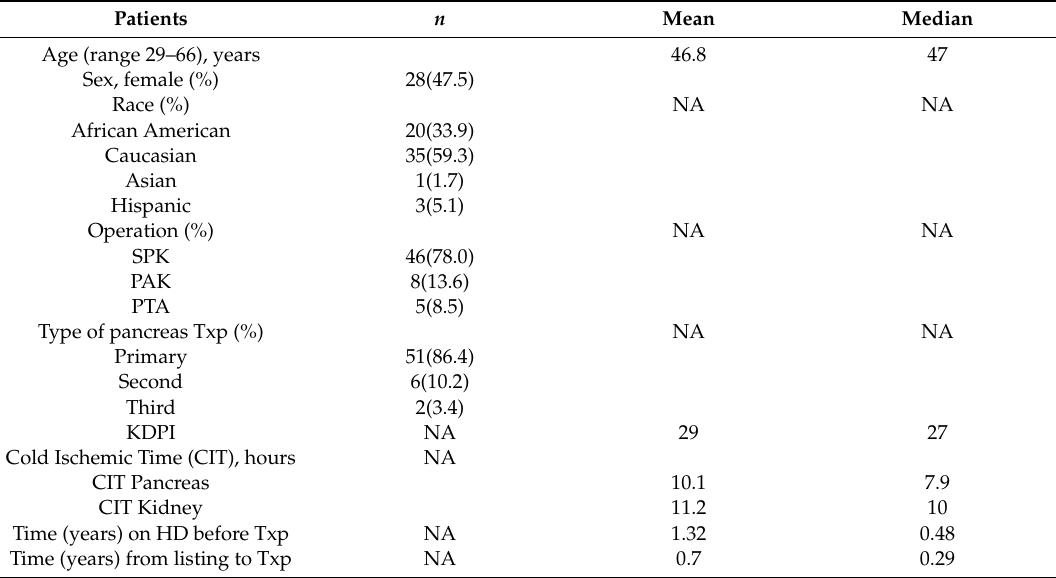
Table 1. Patients undergoing pancreas